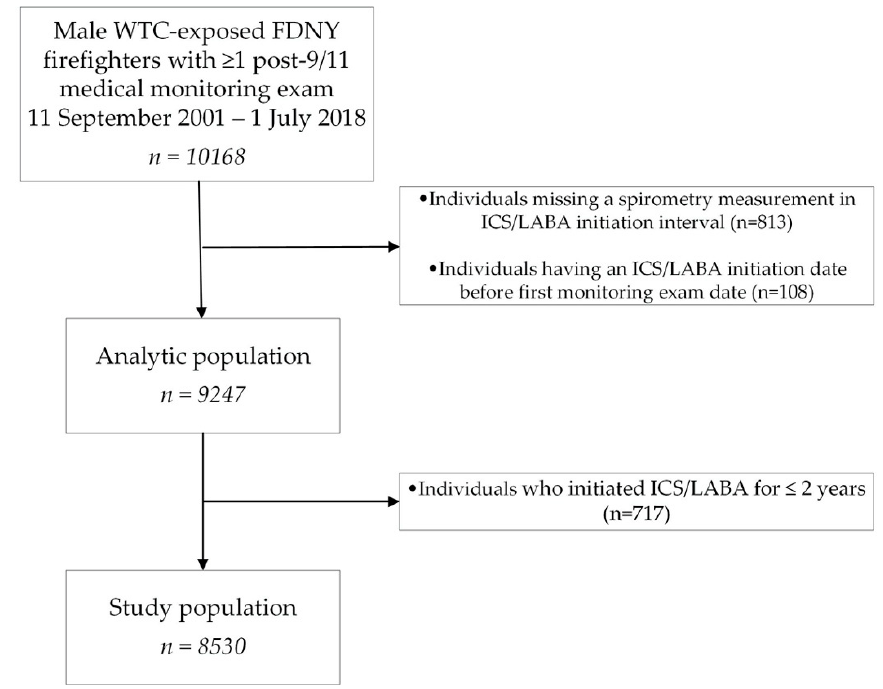
Figure 1 . Flowchart of the study population. The source population included 10168 World Trade Center (WTC)-exposed male firefighters who were actively employed by FDNY on 11 September 2001, consented to research, and had at least one routine medical monitoring exam between 11 September 2001 and 1 July 2018. After applying exclusion criteria for individuals missing a spirometry in the initiation interval or having inhaled corticosteroid/long-acting beta-agonist (ICS/LABA) initiation before first monitoring date, the analytic population included 9247 firefighters. Excluding individuals who initiated ICS/LABA for ≤ 2 years, a study population of 8530 firefighters was established to perform the main analyses.